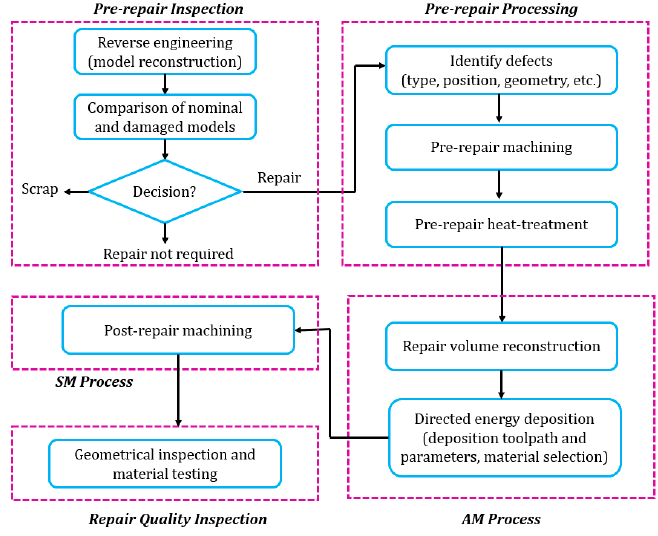
Figure 2. Diagram of the integrated hybrid process.